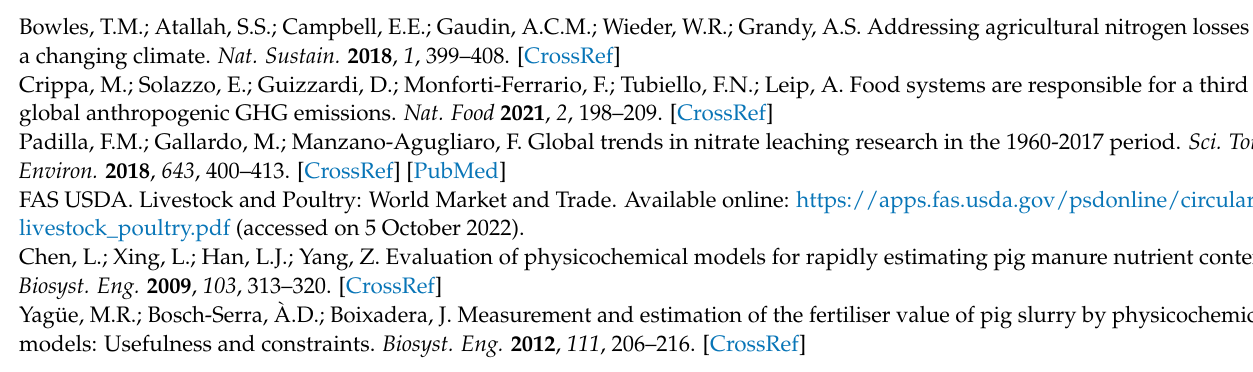
Table S1: Regression models for the total dataset (n = 391) and the subsets piglet (n = 49), pig (n = 232) and sow (n = 110) with coefficients of determination (R 2 ) and RMSE (significance level for all regressions p <